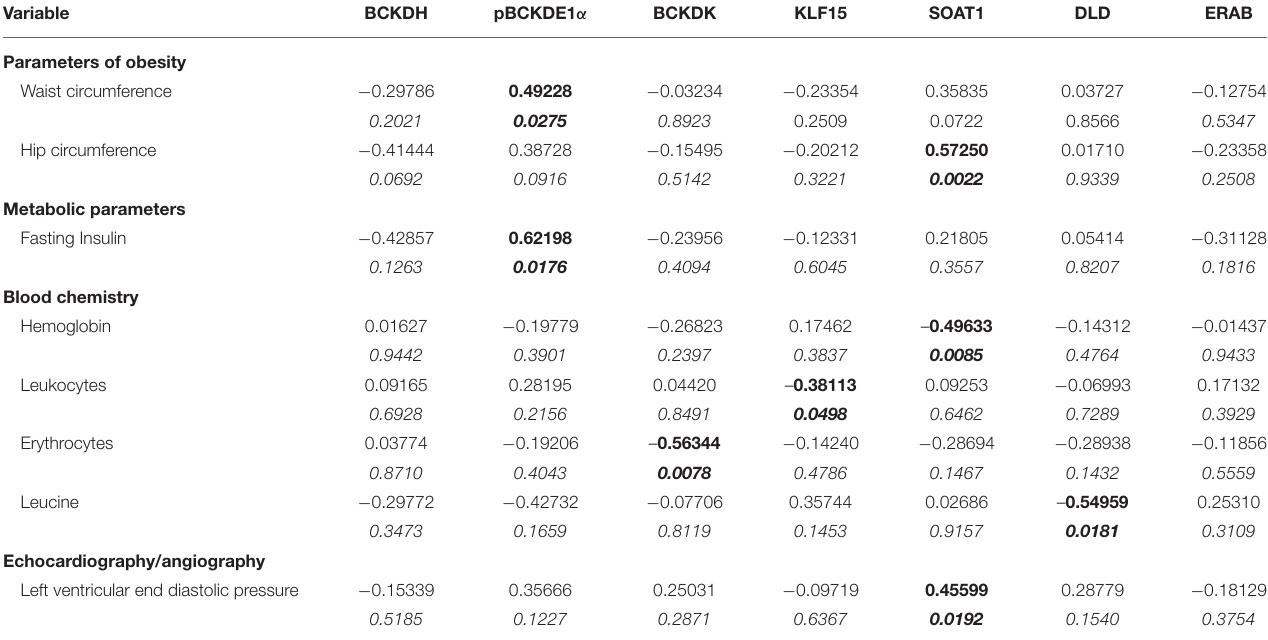
TABLE 2 | Unadjusted Spearman’s correlations for protein expression data of BCAA pathway enzyme in SAT from cardiac surgery patients.